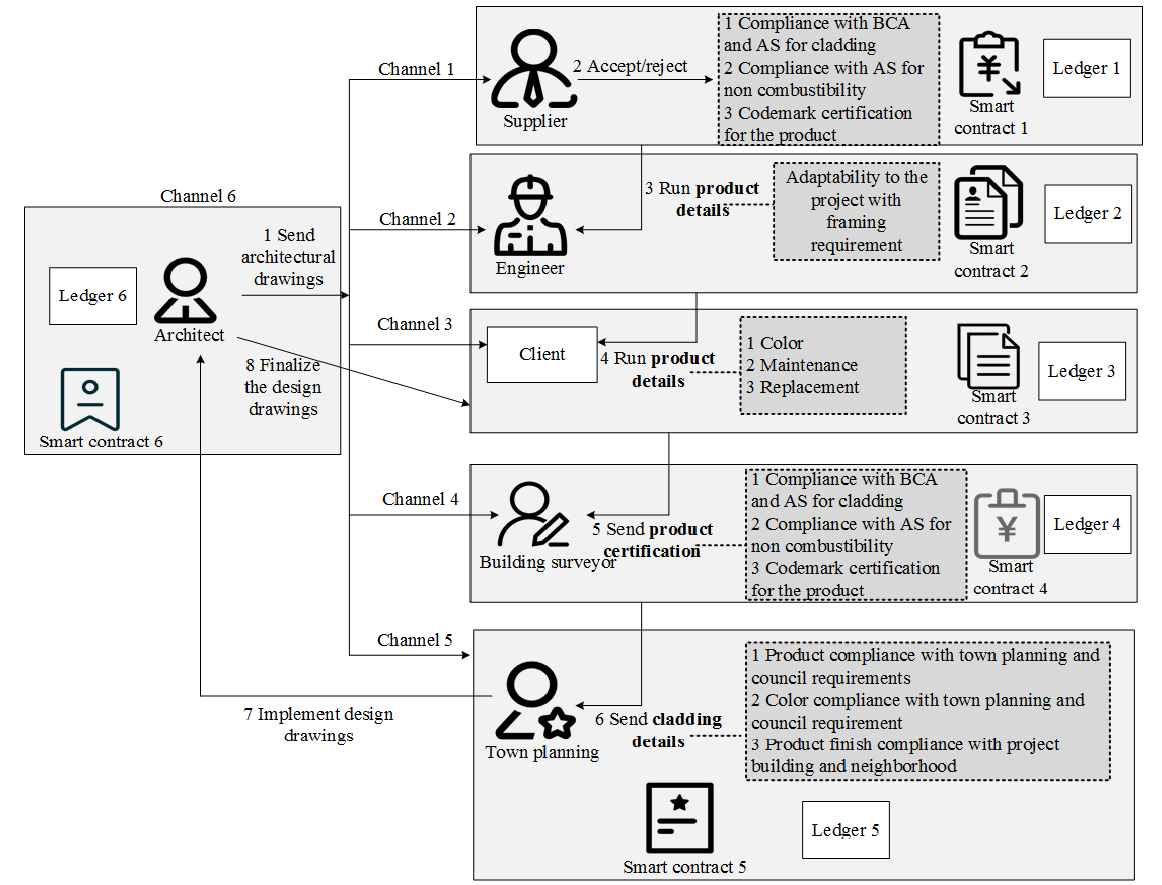
Figure 46. Reconstruction diagram of reference [80].